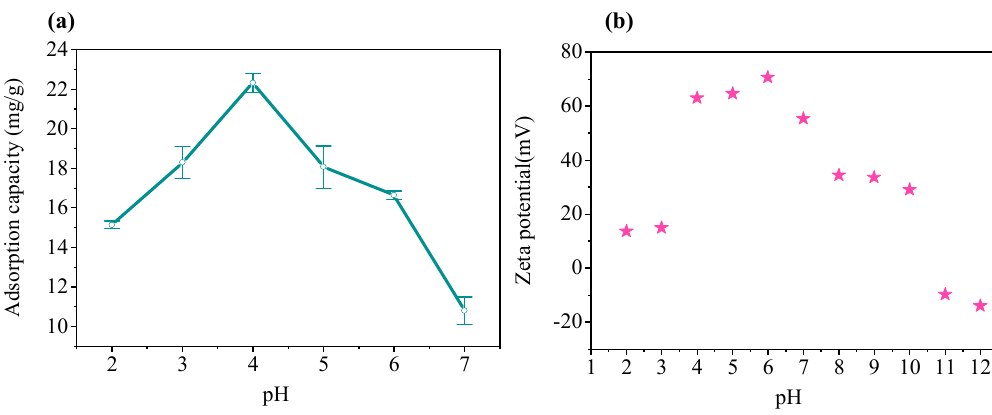
Figure 9. Effect of solution pH on adsorption performance of Cr(VI): ( a ) The influence of pH on adsorption capacity (Conditions: Temperature of 25 °C, and reaction time of 24 h), ( b ) the Zeta potential of Mxene – CS in the aqueous solution.